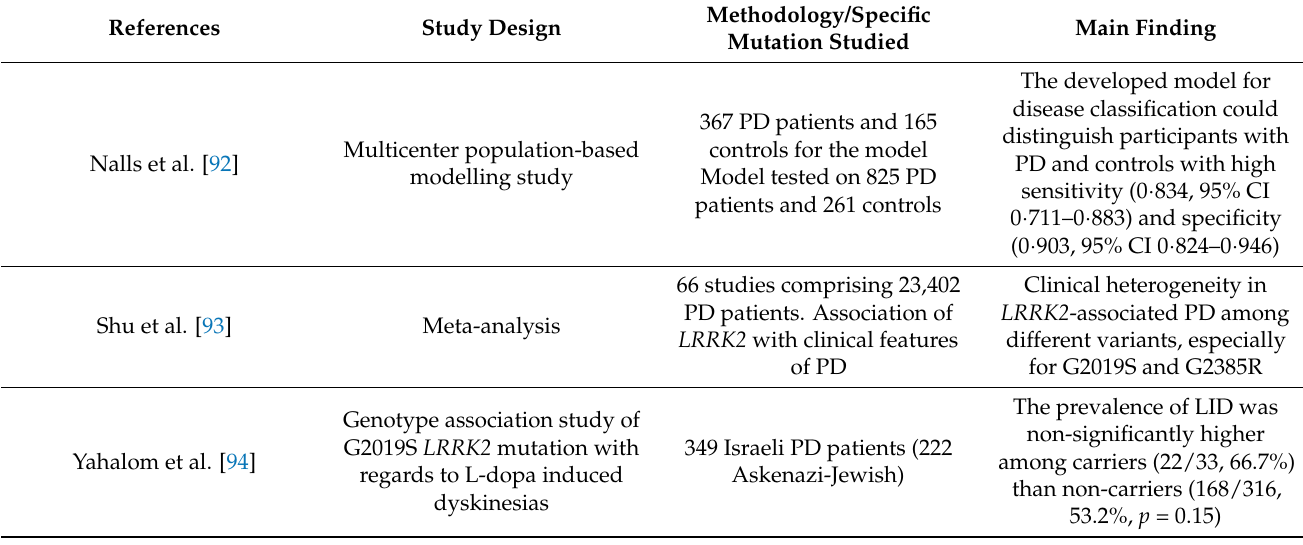
Table 2. Genotype specific Parkinson’s disease studies cited in the